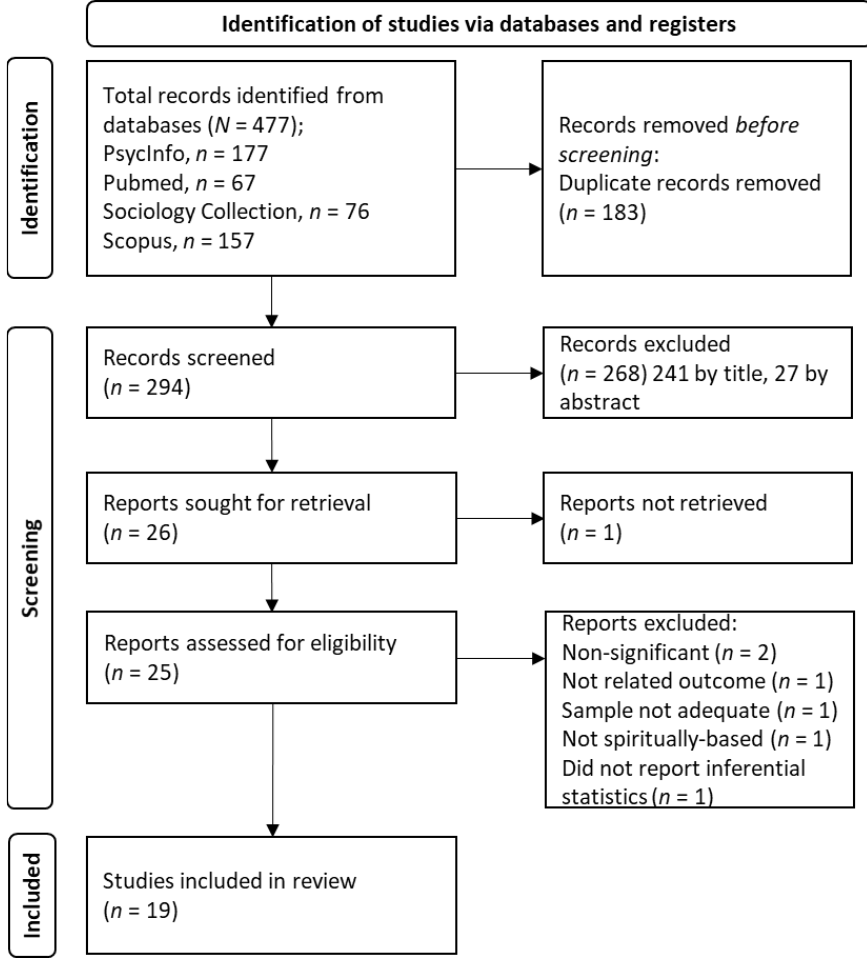
Figure 1. Flow Diagram of the Search and Selection of Studies. Table 1. Design, Main Statistical Analyses and Effect Size (ES) Interpretations in the Studies